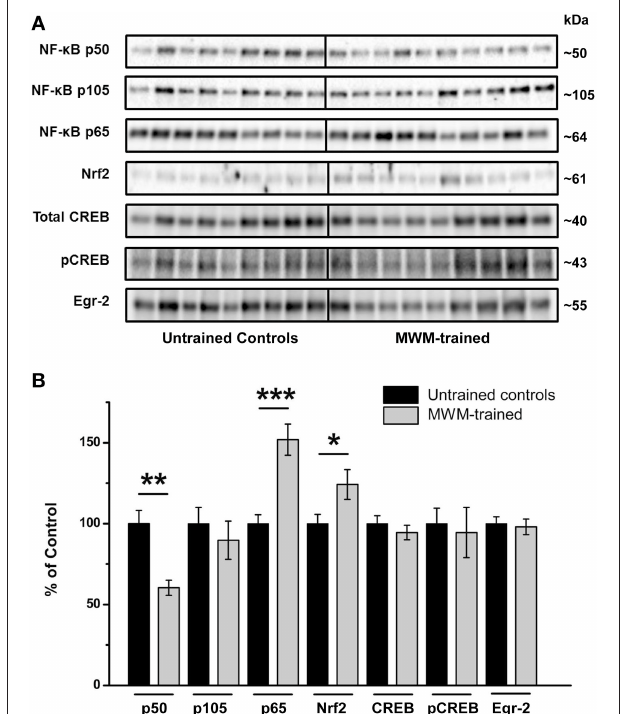
FIGURE 5 | Semi-quantification of transcription factor protein levels in the hippocampus of MWM-trained vs. untrained control CD1 mice. (A) Representative Western blots detecting NF- κ B subunits (p50, p105, and p65), Nrf2, CREB (total and activated pCREB), and Egr-2. All samples ( n = 9 –10/group) were immunoblotted simultaneously using 26-well Criterion TM TGX Stain-Free TM gels (Bio-Rad). (B) Bar graph of densitometry values of transcription factors of interest, normalized to total protein and expressed as percentage change from control mean (100%) ± SEM, from hippocampal homogenates from untrained controls and MWM-trained mice. * p < 0.05 ; ** p < 0.01 ; *** p < 0.001